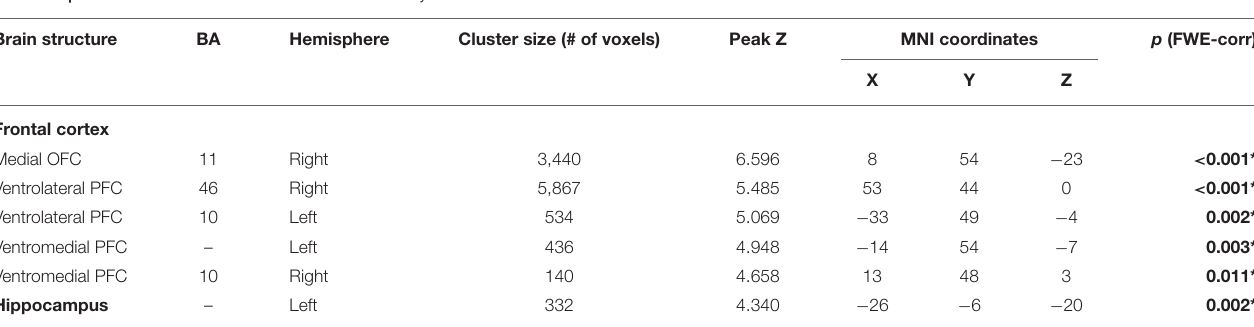
TABLE 4 | Main effects of time in structural MRI ROI